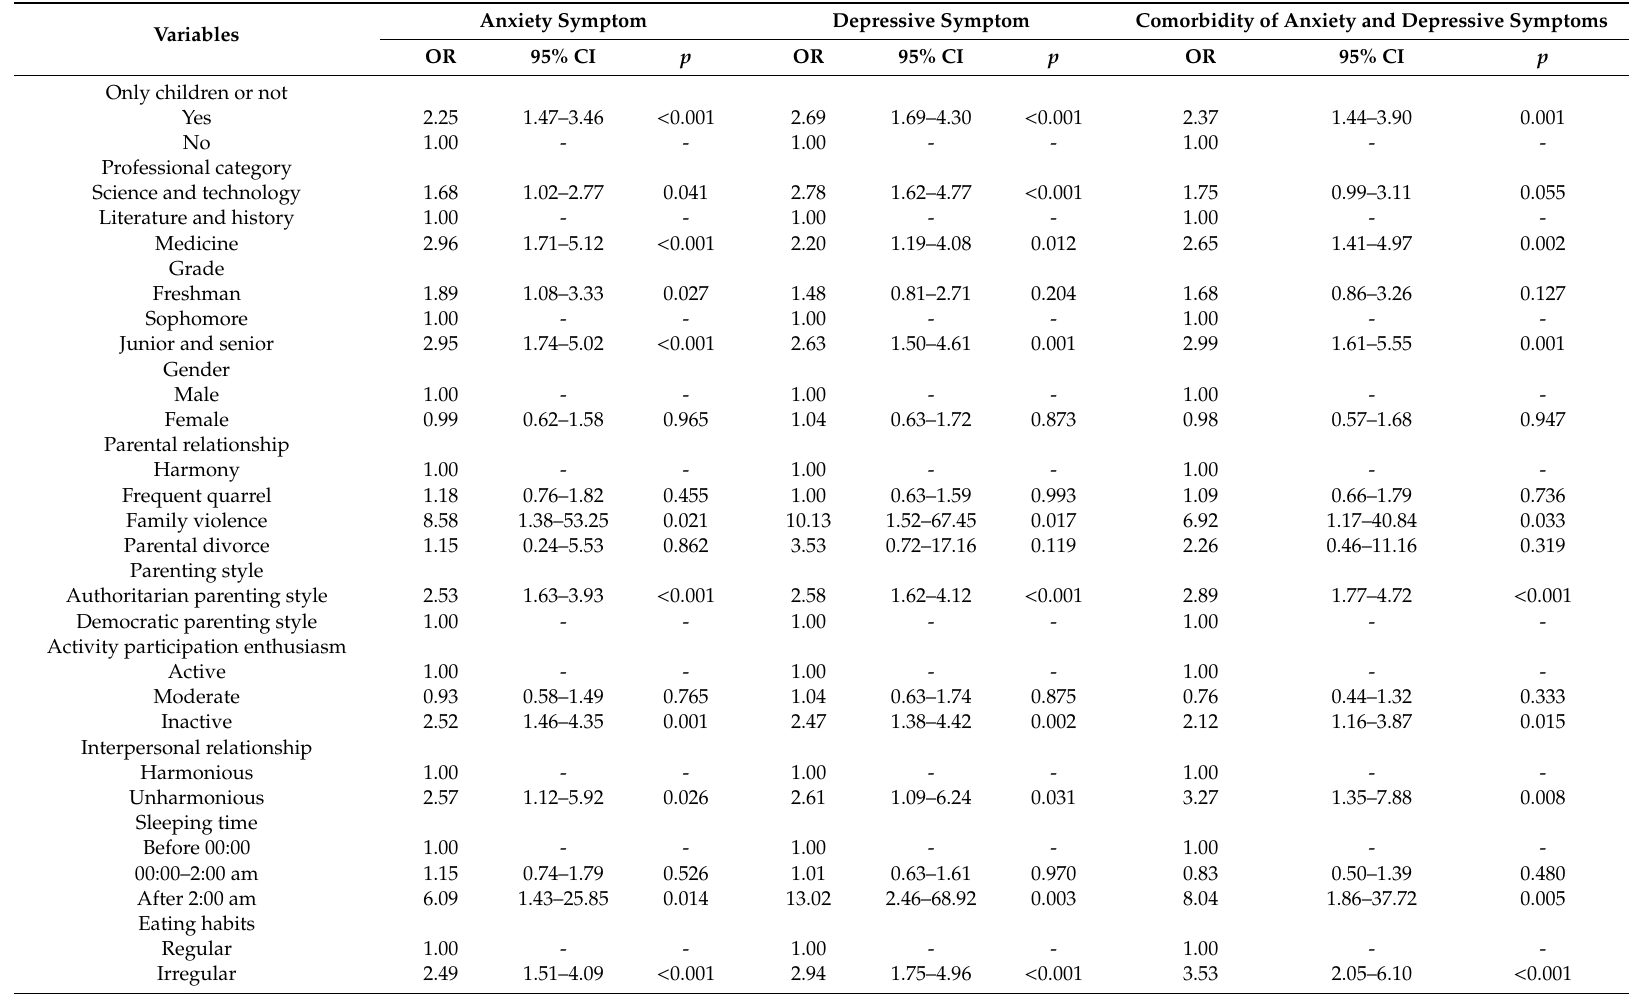
Table 3. Logistic regression analysis of association between only children and anxiety symptom, depressive symptom, comorbidity of anxiety and depressive